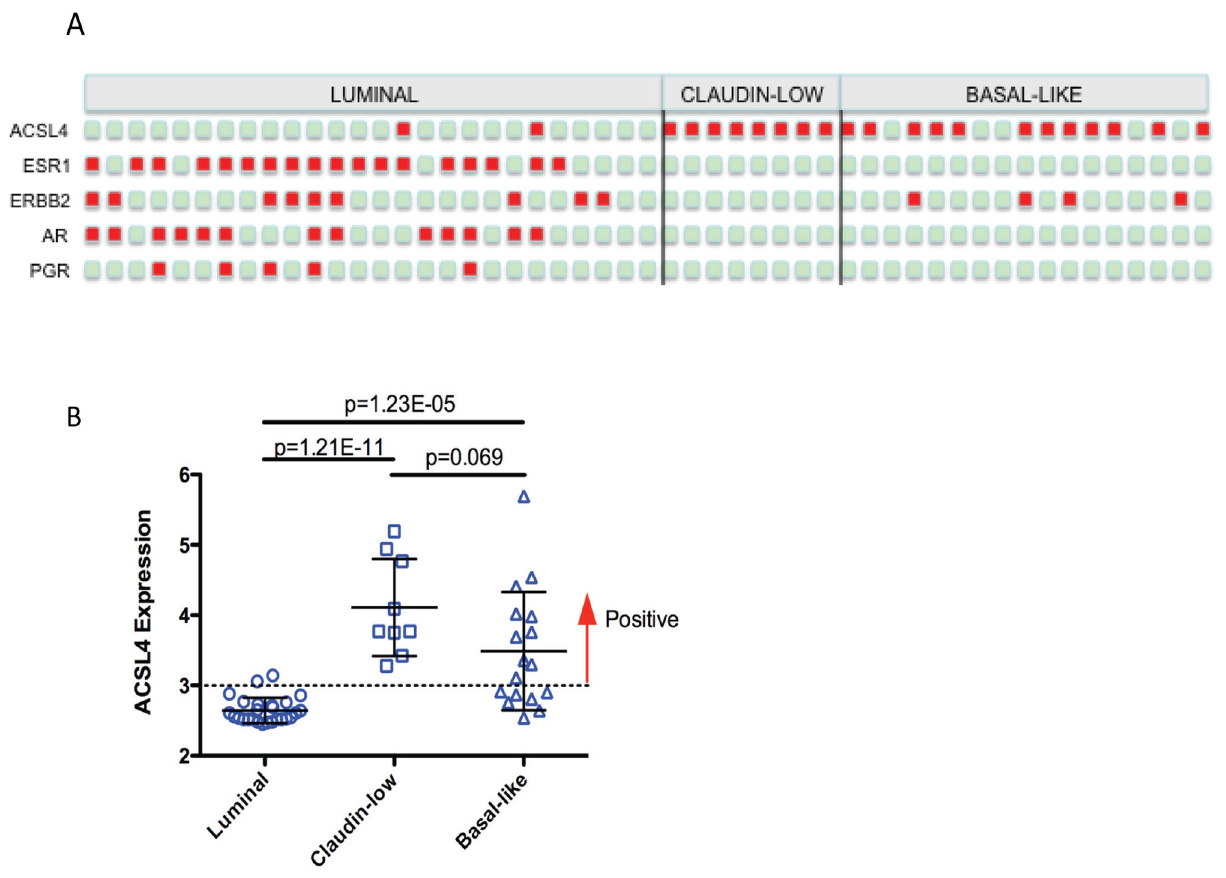
Figure 1. ACSL4 expression as a function of intrinsic molecular subtype. Microarray expression data and subtype allocations of 52 human breast cancer cell lines were obtained from previously published data [21,30]. Panel A lists expression status for ACSL4, ER (ESR1), HER2 (ERBB2), AR and PR (PGR). Green squares are negative for expression and red squares are positive. Identification of individual cell lines can be found in reference 30 (note: HBL-100, included in reference 30, was not included in this figure). Panel B shows ACSL4 mRNA relative expression values as a function of the molecular subtype of individual cell lines. Means and 1SD are shown, as well as the p values for the differences between